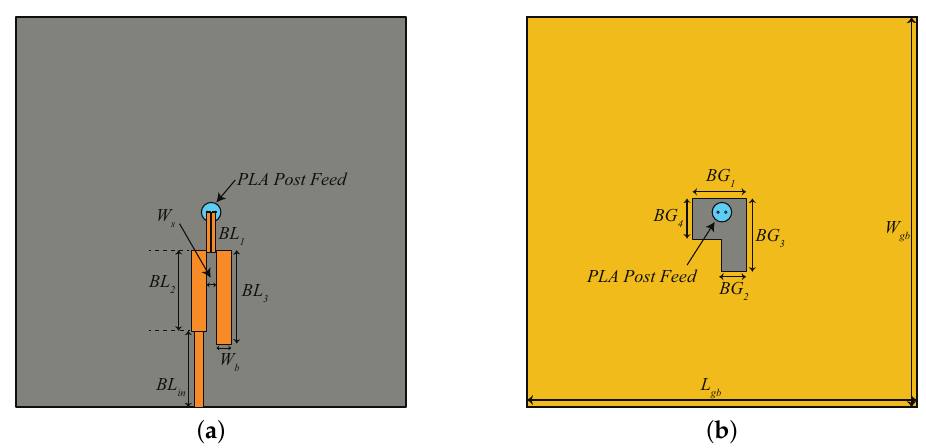
Figure 15. Balanced to Unbalanced (Balun) design ( a ) Top view ( b ) ground plane. The simulated results of the balun structure shown in Figure 15 are displayed in Figure 16. As shown in Figure 16a, the transmission parameter between port 1 and 2 varies between − 1.2 dB and − 1.5 dB within the UWB band. Slightly worse, but still acceptable, performance are achieved at 868 MHz. Of course, the balun design is the result of a delicate trade-off between the performance in the two distant frequency ranges. Next, this balun is deployed behind the Iteration 2 design. One can note that the removal of the ground plane has been limited as much as possible in order not to affect the role of the HIS, even if this cannot be completely assured, as described later.